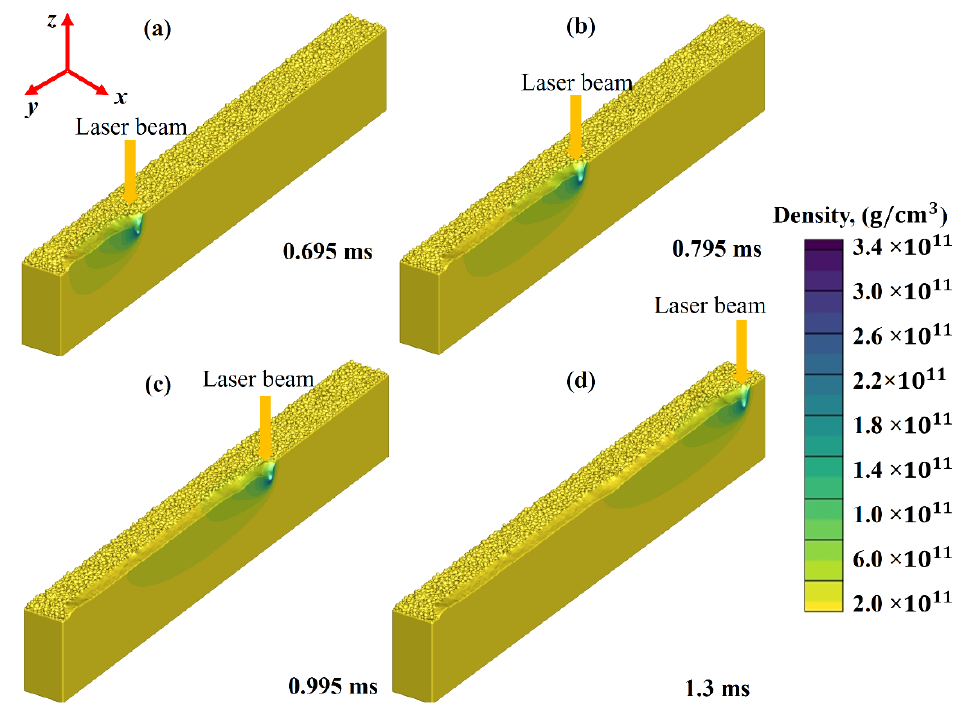
Figure 6. Density evolution of the melt pool at various time intervals ( a ) 0.695 ms, ( b ) 0.795 ms, ( c ) 0.995 ms and ( d ) 1.3 ms.